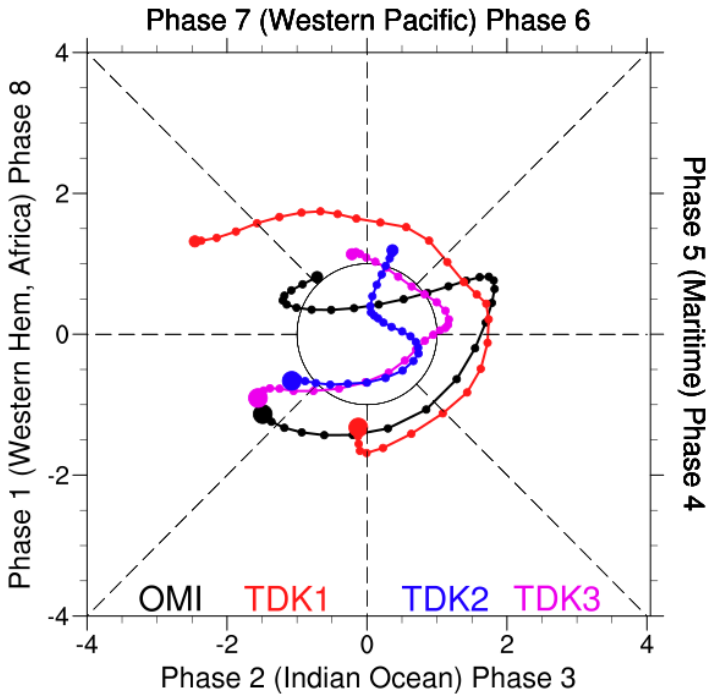
Figure 2. Phase diagram of OMI (black line), TDK1 (red line), TDK2 (blue line), and TDK3 (purple line) from 13 November to 13 December 2011. The dates divisible by 1 are labeled using the points. Colored lines represent different model results. The principal components (PCs) of the model results are normalized by the standard deviation (245.642 W m −2 ) of PC 1 based on NOAA OLR.